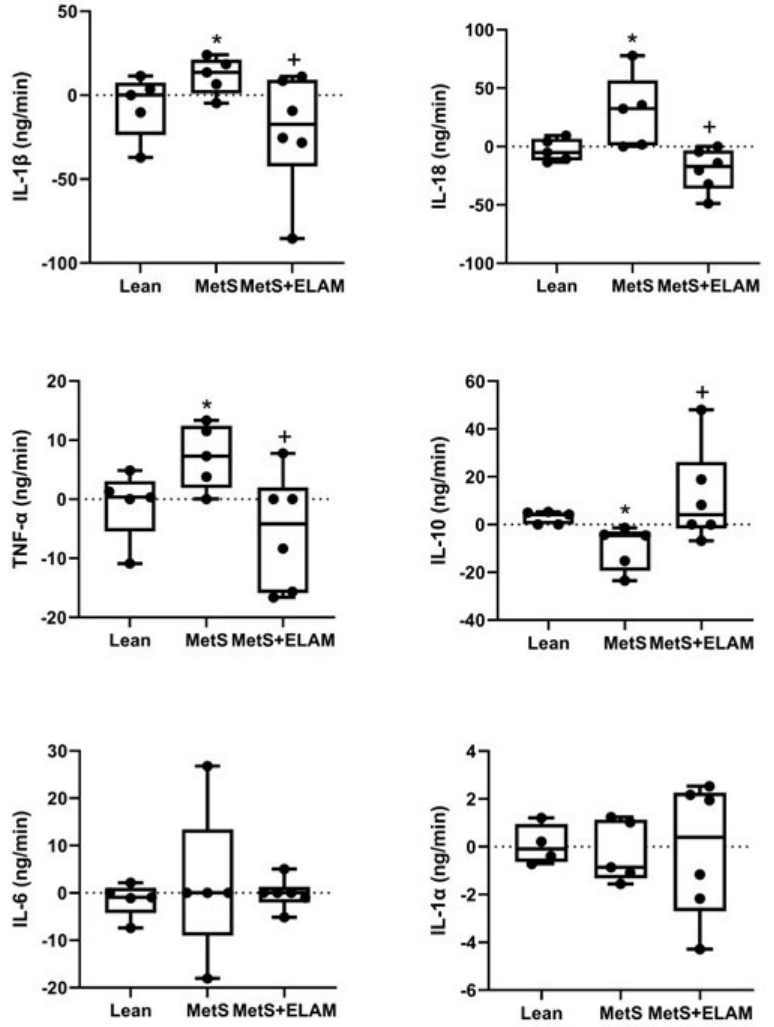
Figure 5. Renal production of inflammatory markers. The renal net release of the inflammatory cytokines IL-1 β , IL-18, and TNF- α increased in MetS and decreased after ELAM treatment, whereas IL-10 decreased in MetS pigs and improved in MetS + ELAM pigs. * p < 0.05 vs. lean, + p < 0.05 vs.